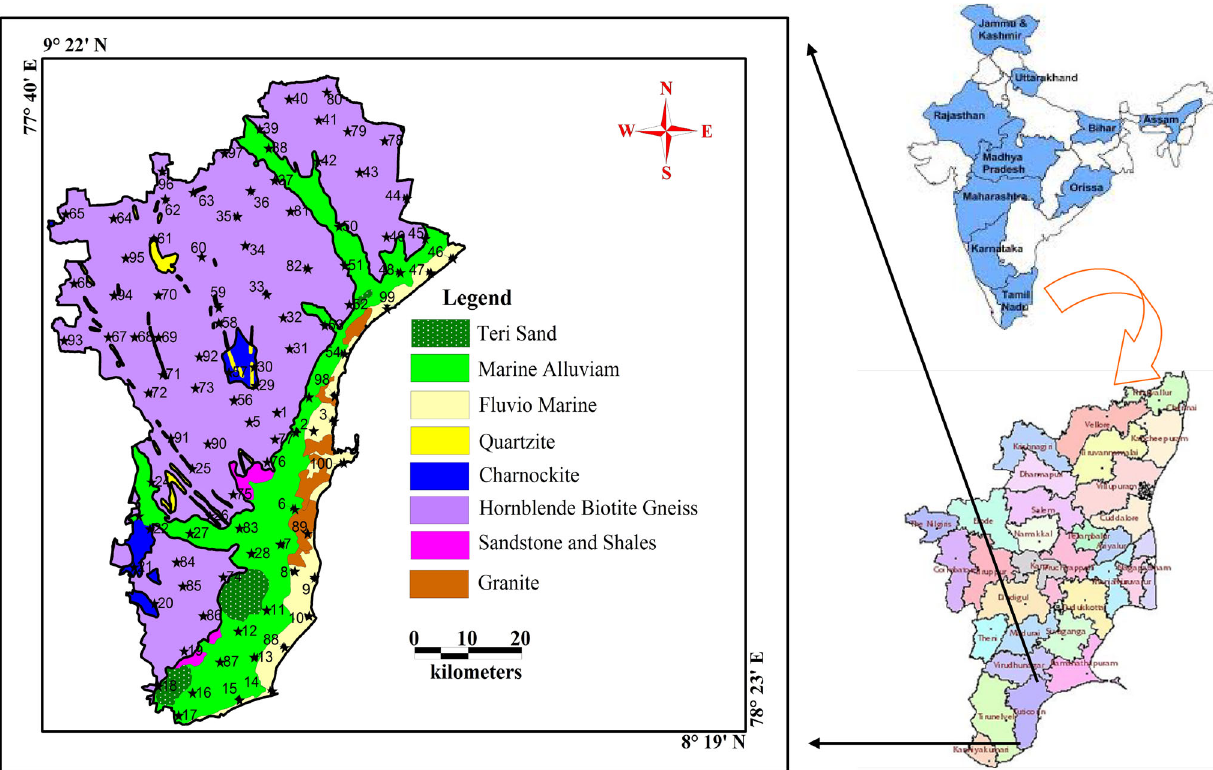
Fig. 1 Sampling location and geology map of the study area